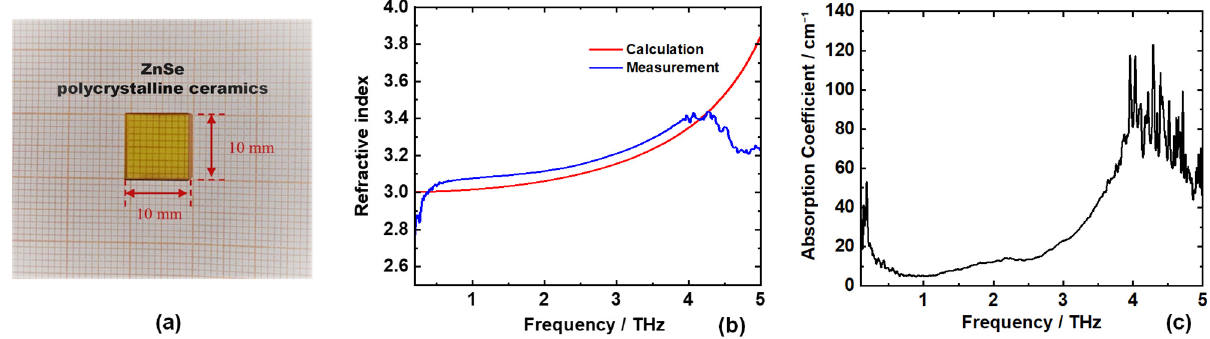
Figure 1. Polycrystalline ZnSe and its optical property in the terahertz range: ( a ) photo of the sample; ( b ) refractive index; ( c ) absorption coefficient.